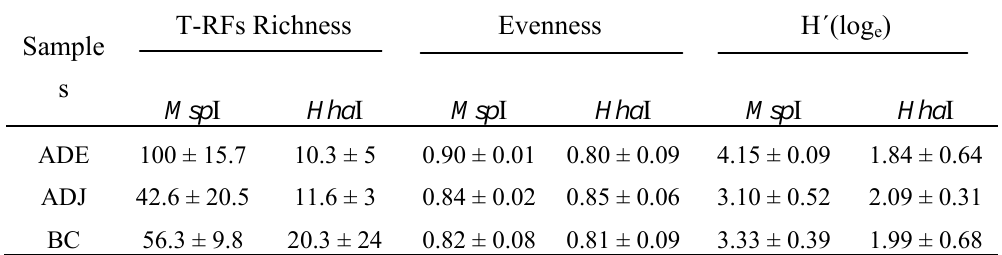
Table 4. Diversity index and richness estimation of T-RFs for ADE and ADJ soil and BC based on enzymes Msp I and Hha I